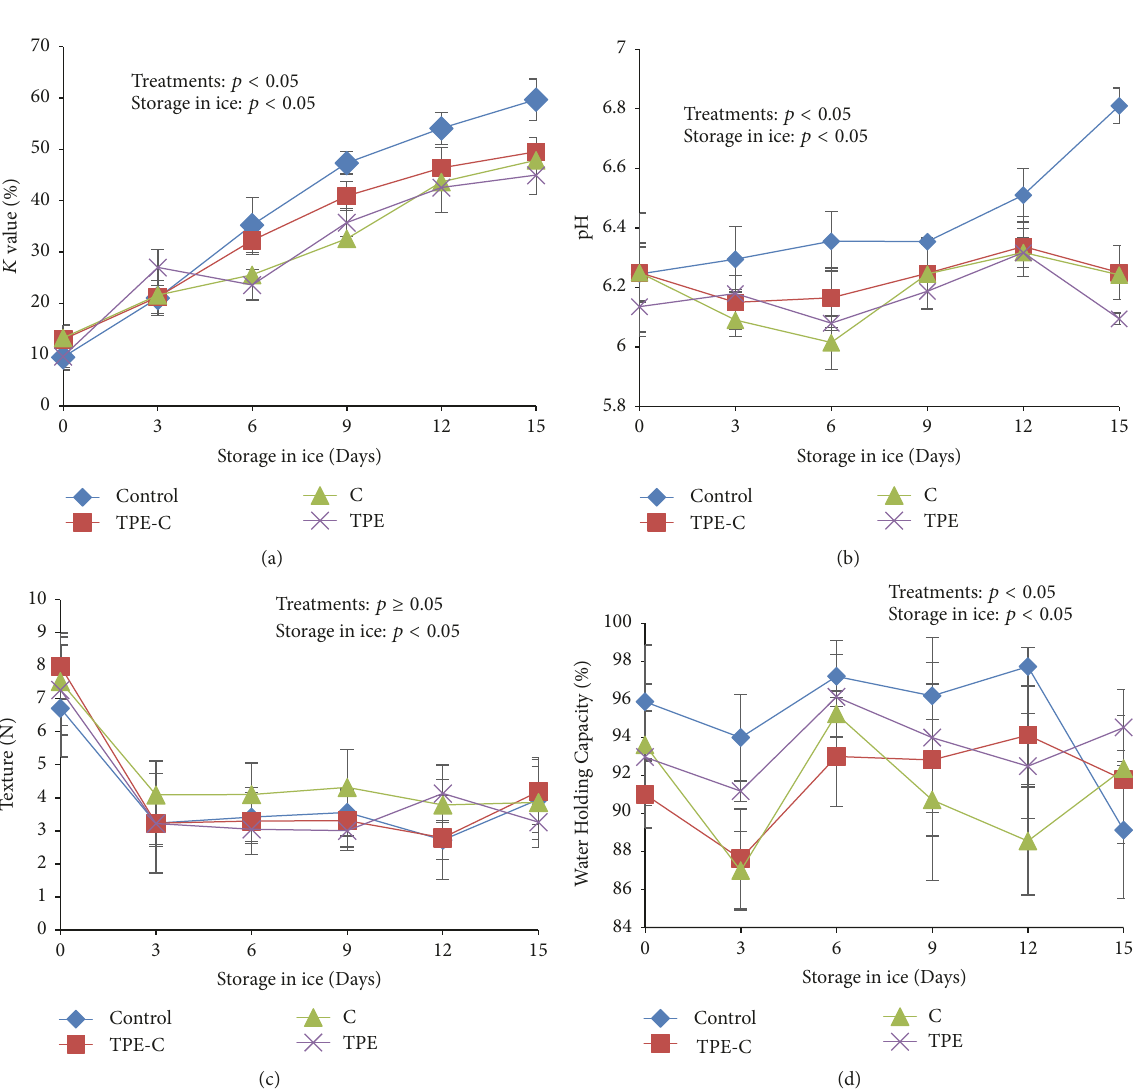
Figure 2: Behavior of 𝐾 value, pH, texture, and water holding capacity in fillets of sierra (Scomberomorus sierra) with different treatments: (a) control, (b) tomato plan extract, (c) chitosan, and (d) tomato plant extract-chitosan, stored during 15 days in ice. The values are the average of 𝑛 = 4 ± the standard deviation and